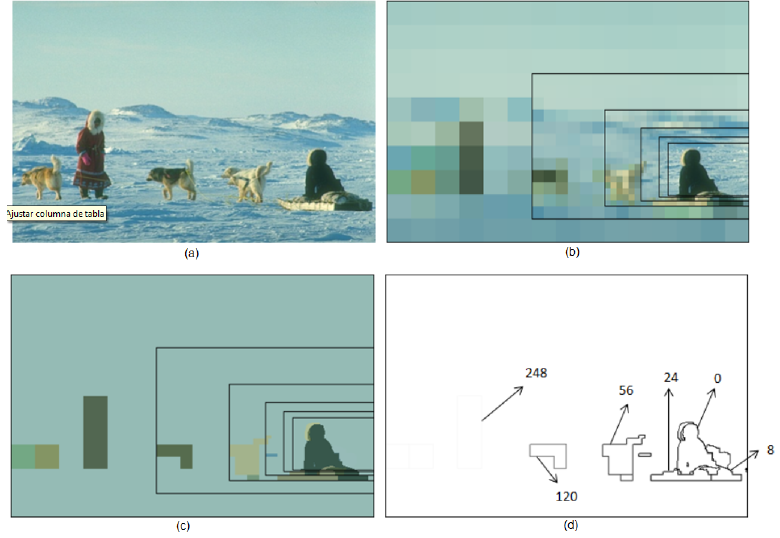
Figure 14. ( a ) Image #310007 of the BSDB500; ( b ) One foveal image; ( c ) Segmentation image; and ( d ) Associated contour